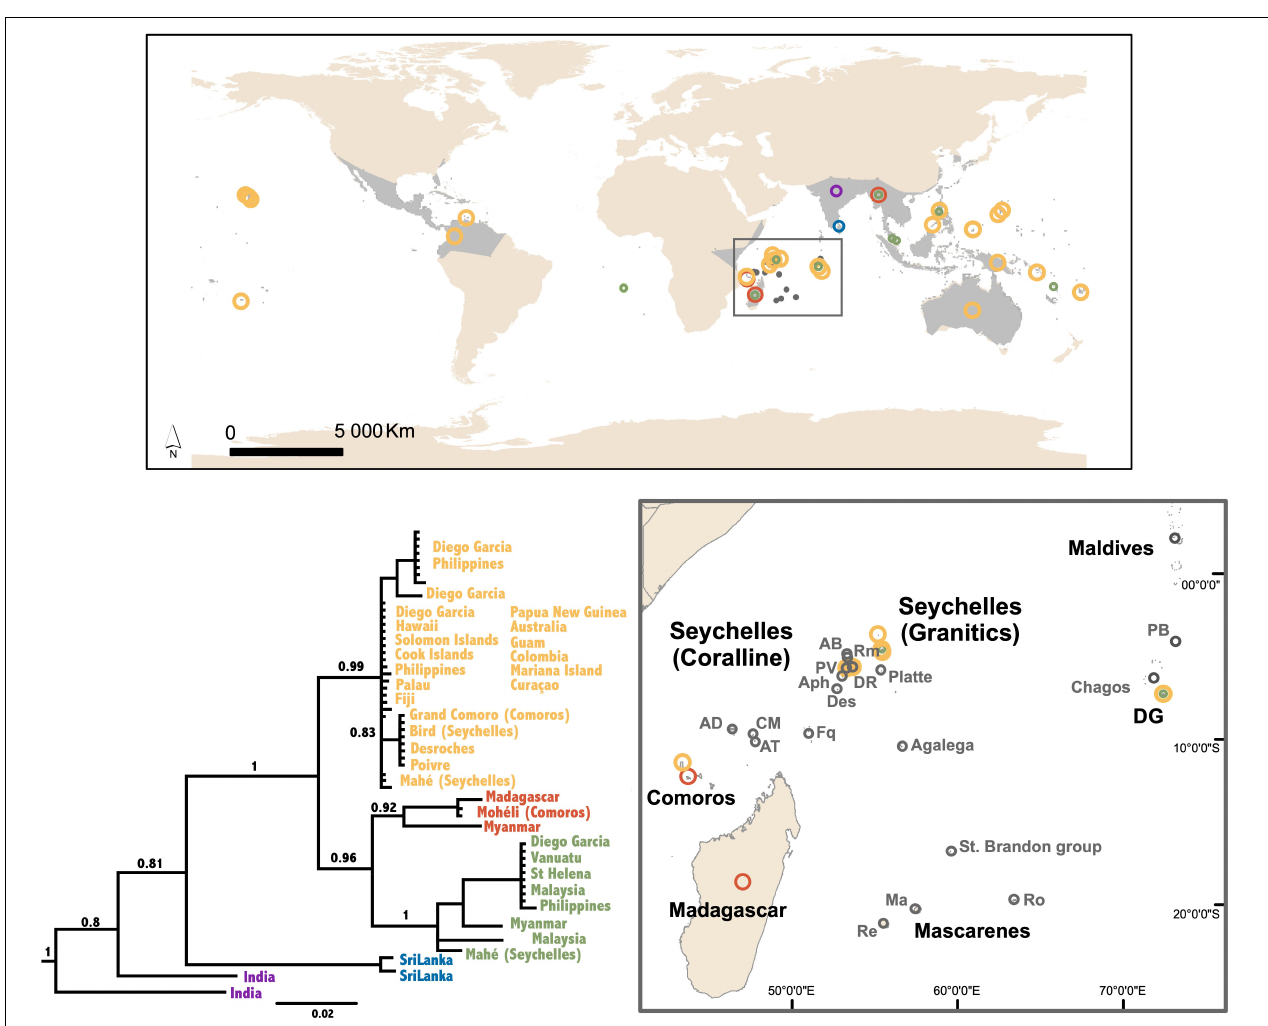
FIGURE 3 | (Top) A map showing the location of modern and museum samples that yielded sufficient DNA to be included in this study. The colors on the map mirror those of the clades on the phylogenetic tree depicting the relationships of the Cytochrome b lineages. The light gray shading denotes the modern distribution of H. frenatus retrieved from GBIF records and converted into polygons (GBIF.org; 29 November 2021- GBIF Occurrence download https://doi.org/10.15468/dl.s8w3sw). (Bottom left) A schematic representation of the Bayesian consensus tree (full tree in Supplementary Figure 1 ). Branches leading to the outgroups are not shown and posterior probabilities are shown for the main branches only. Tips are labeled with the different localities where samples from each lineage originate, and are color-coded to match the distribution maps. (Bottom Right) An inset depicting the relevant locations across the Western Indian Ocean discussed in the main text. Location acronyms are as follows: Reunion (Re); Mauritius (Ma), Rodrigues (Ro), Peros Baños (PB), African Banks (AB), Rémire (Rm), Poivre (PV), Desroches (DR), Alphonse (Aph), Desnoeufs (Des), Farquars (Fq), Aldabra (AD), Cosmoledo (CM) and Astove (AT). St. Brandon group including Sírene and Establishment (= Île